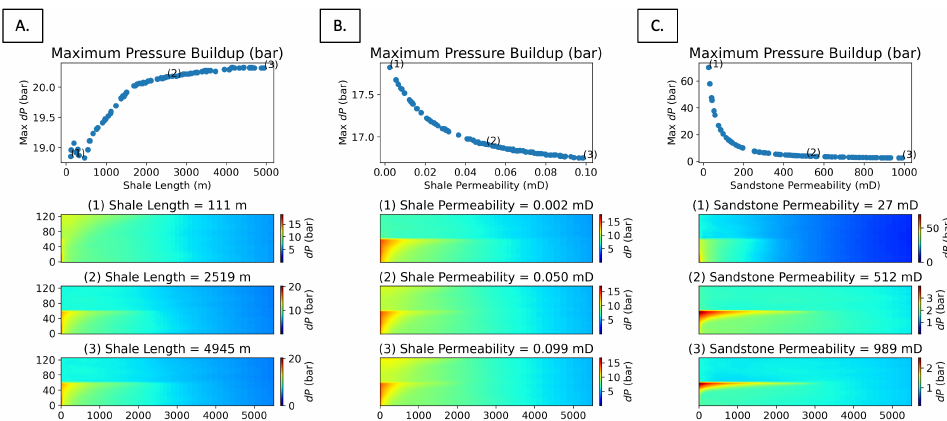
Figure 5. Analysis of pressure buildup with respect to ( A ) shale length, ( B ) shale permeability, and ( C ) sandstone permeability. Each subfigure shows the data, as well as visual examples of three simulated scenarios that are annotated on the first plot.